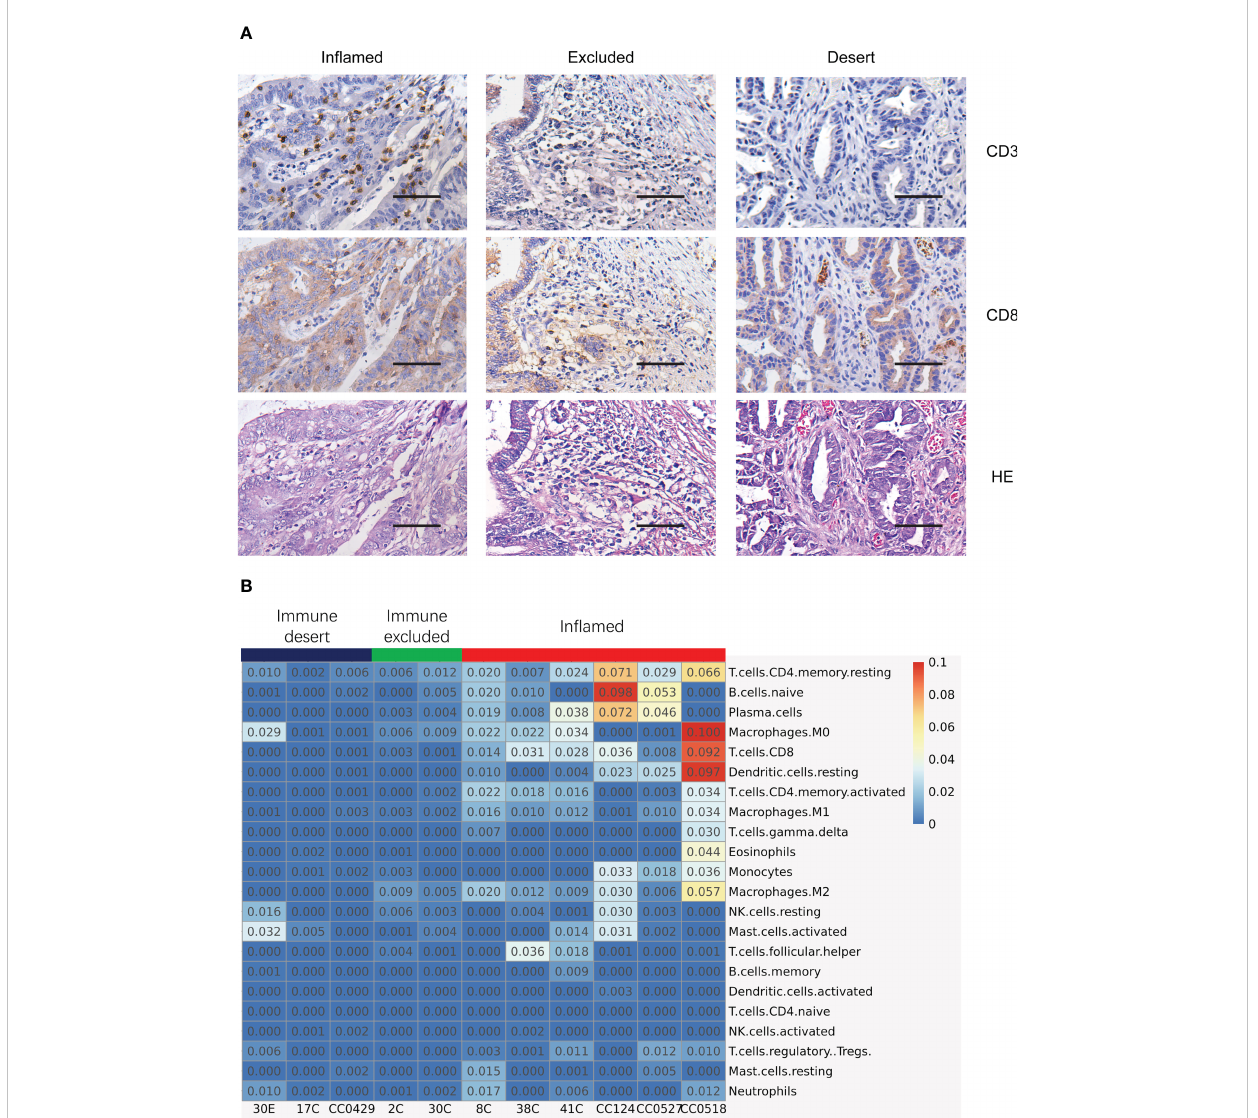
FIGURE 2 Typing the tumor immune signatures in MMR-de fi cient tumors by the integration of histology and transcriptome pro fi le. (A) Immunostaining of CD3, CD8, and HE exhibits the patterns of various tumor immune signatures in different MMR-de fi cient tumors. Magni fi cation: 50×, scale bar: 100 m m. (B) Deconvolution analysis of RNA-seq data reveals the in fi ltration of different populations of immune cells in various tumor immune signatures. The relative fraction of 22 immune cell types is inferred by